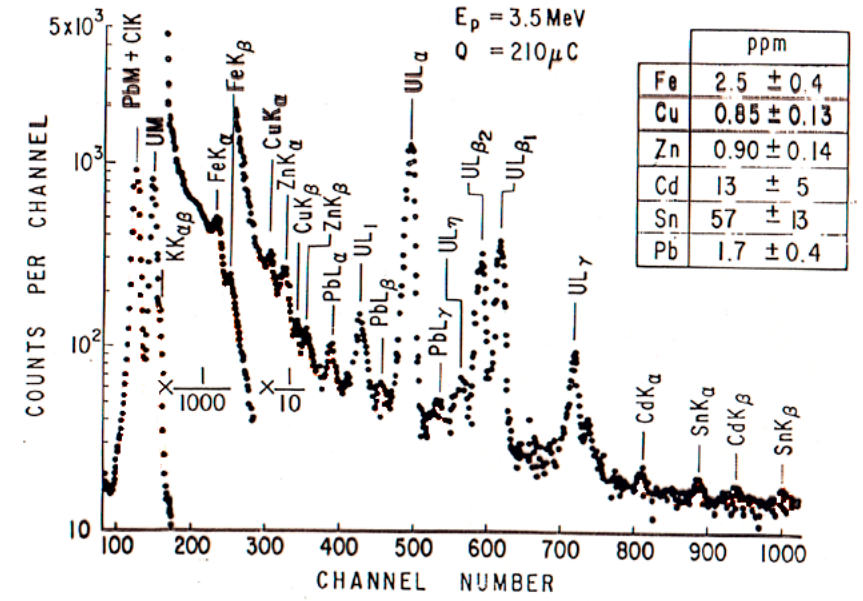
Figure 5. Analysis of canned tomato juice.